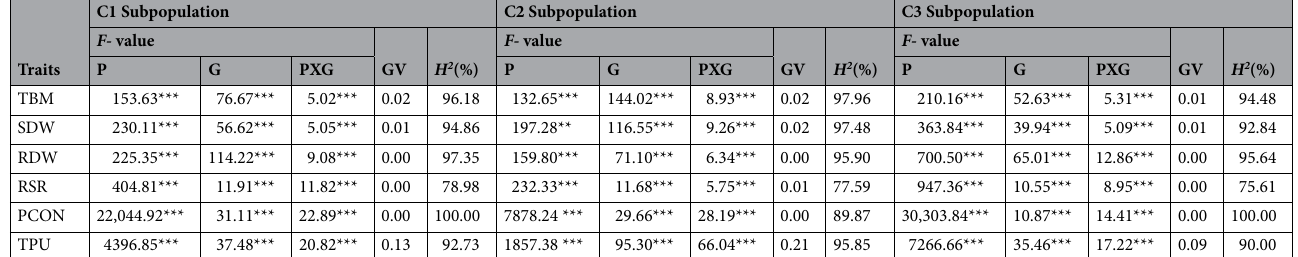
Table 4. ANOVA, genetic variance (GV) and broad sense heritability ( H 2 ) for P use efficiency related traits recorded in three subpopulations (C1, C2 and C3), obtained from 82 bread wheat accessions, grown under sufficient (500 µM) and low (5 µM) concentration in hydroponics. Abbreviations: TBM, total biomass; SDW, shoot dry weight; RDW, root dry weight; RSR, root-to-shoot ratio; PCON, phosphorus concentration; TPU, total phosphorus uptake. * P < .05; ** P < .01, *** P < .001; P – phosphorus; G – accession; PXG – interaction between P and G.